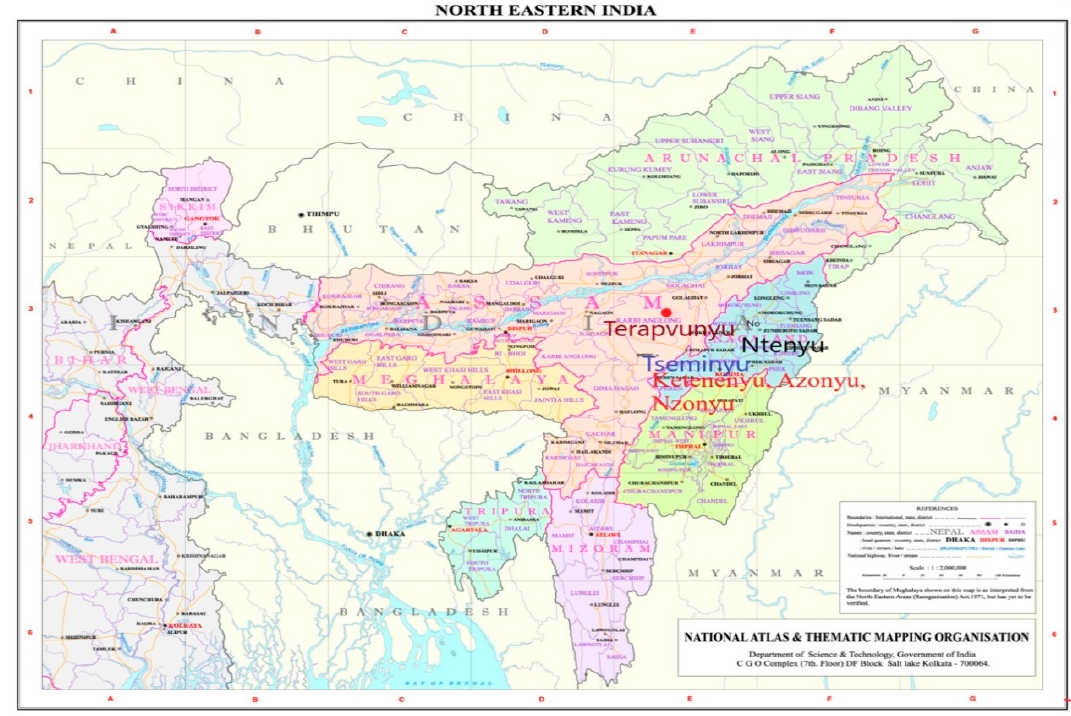
Figure 1. Rengma speaking areas in Northeast India (Map of Northeast India 2019).